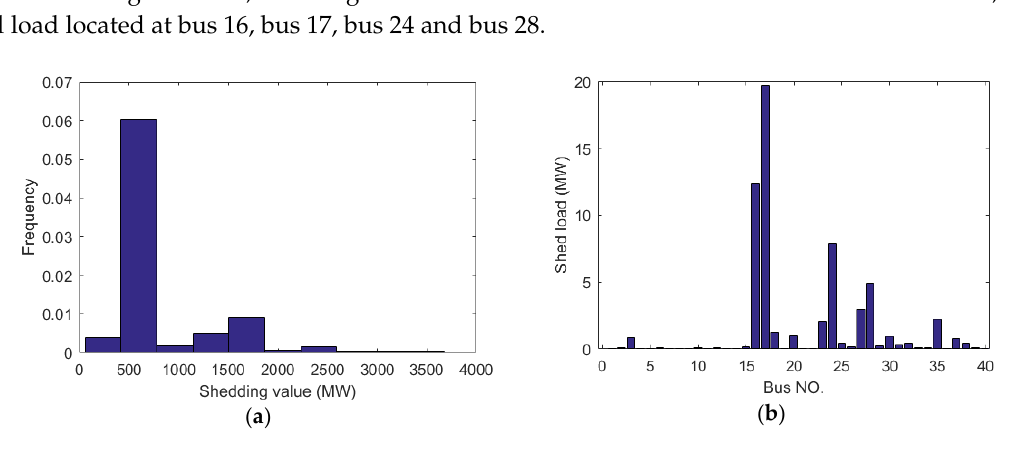
Figure 14. The feature of shedding. ( a ) Histogram of shedding values; and ( b ) shedding value per state on each DC bus.